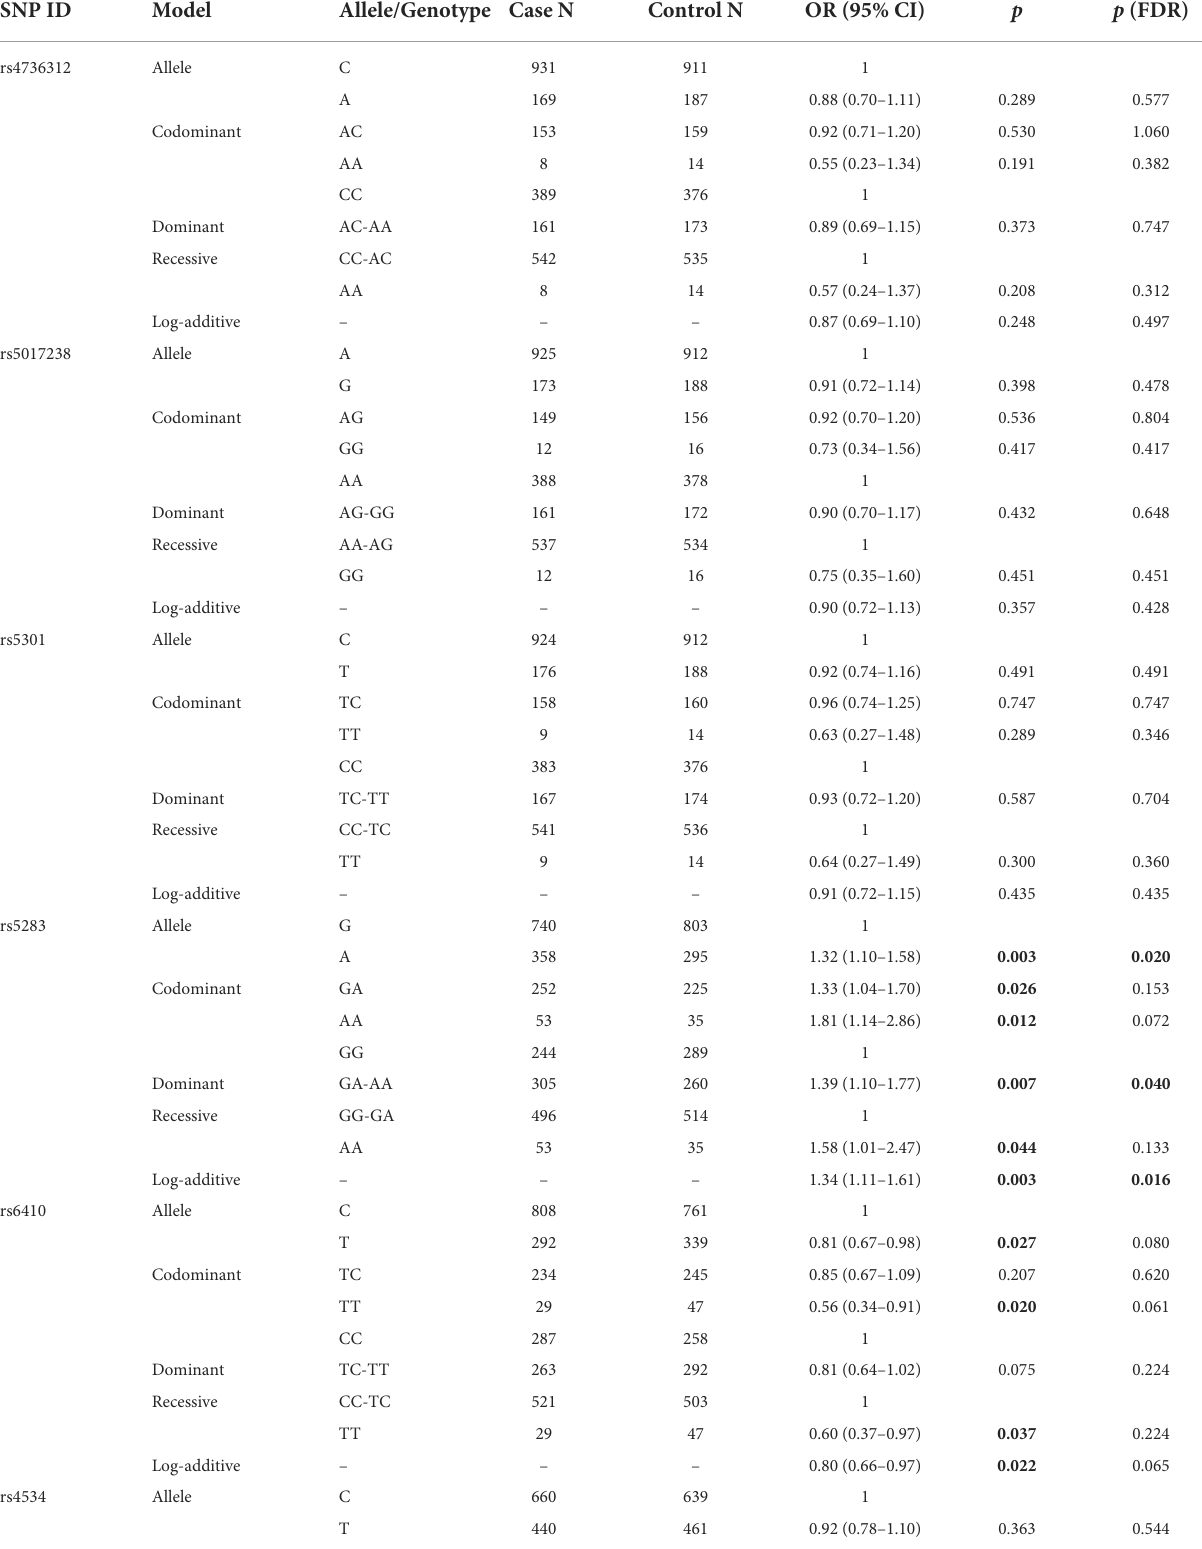
TABLE 3 Association between CYP11B1 gene polymorphisms and ischemic stroke